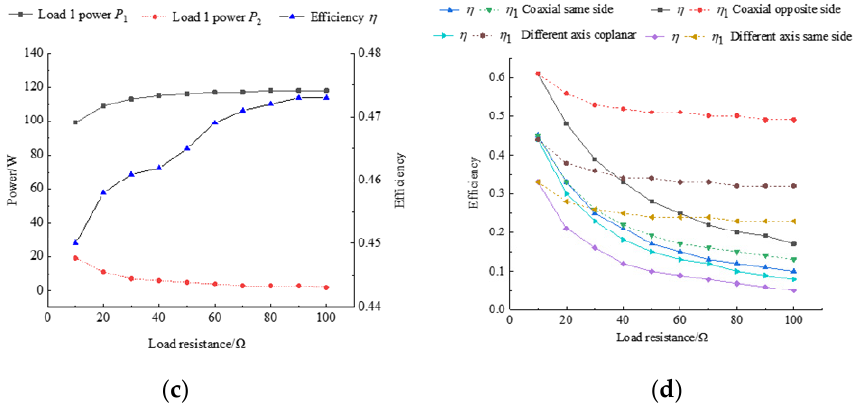
Figure 14. Load resistance and system parameter curves. ( a ) Double load synchronous change. ( b ) Only load 1 changes. ( c ) Only load 2 changes on the same side of the coaxial. ( d ) Efficiency curve. Table 1. Parameters of the transmitting and receiving coil. Symbol Transmiting Coil Receiving Coil 1 Receiving Coil 2 Inductance, L / µ